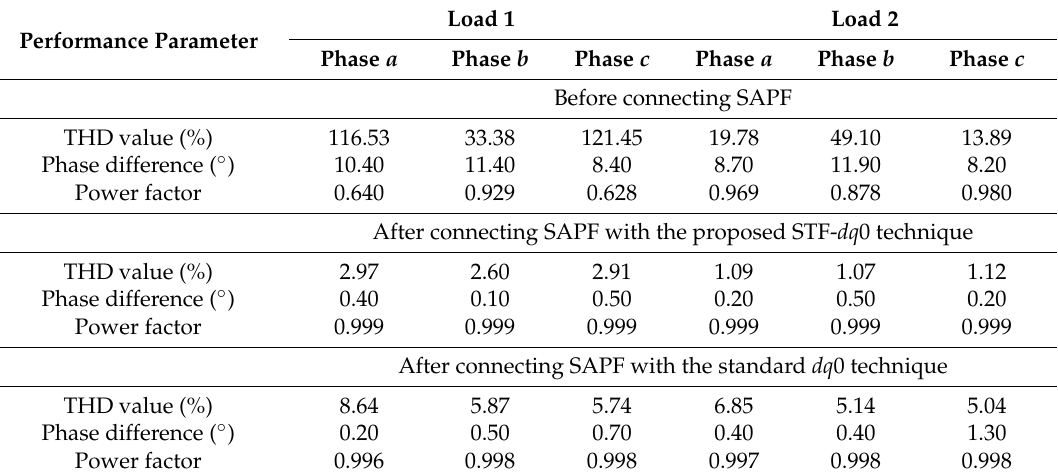
Figure 24. Simulation result obtained under Scenario D for Load 2, showing the total dc-link voltage V dc , and voltages across split dc-link capacitors V dc 1 and V dc 2 , demonstrated by SAPF while applying the proposed STF- dq 0 technique. Table 5. Comparative analysis of the proposed STF- dq 0 and the standard dq 0 techniques under Scenario